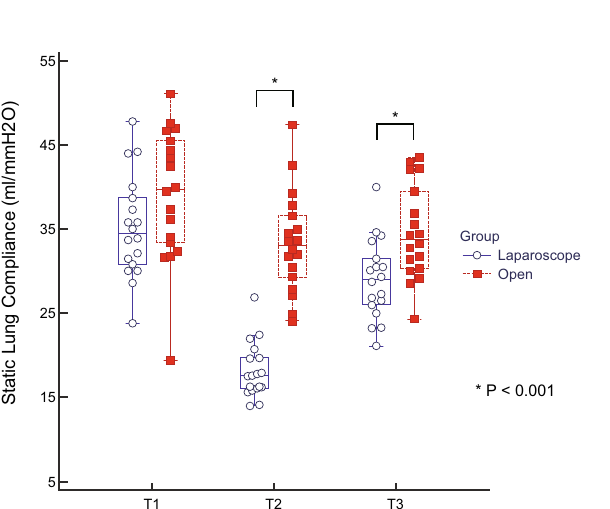
Figure 2. Static lung compliance during each type of surgery. Box-and-whisker plots of static lung compliance in patients who underwent laparoscopic (blue box) and open (red box) radical hysterectomy. Static lung compliance in patients who underwent laparoscopic surgery was reduced significantly during the operation and was significantly lower than in the open-surgery group at the end of the operation (P < 0.001). *The two groups differed significantly. T1 = after intubation; T2 = 90 min after the incision; T3 = at the end of the operation with recovery of muscle